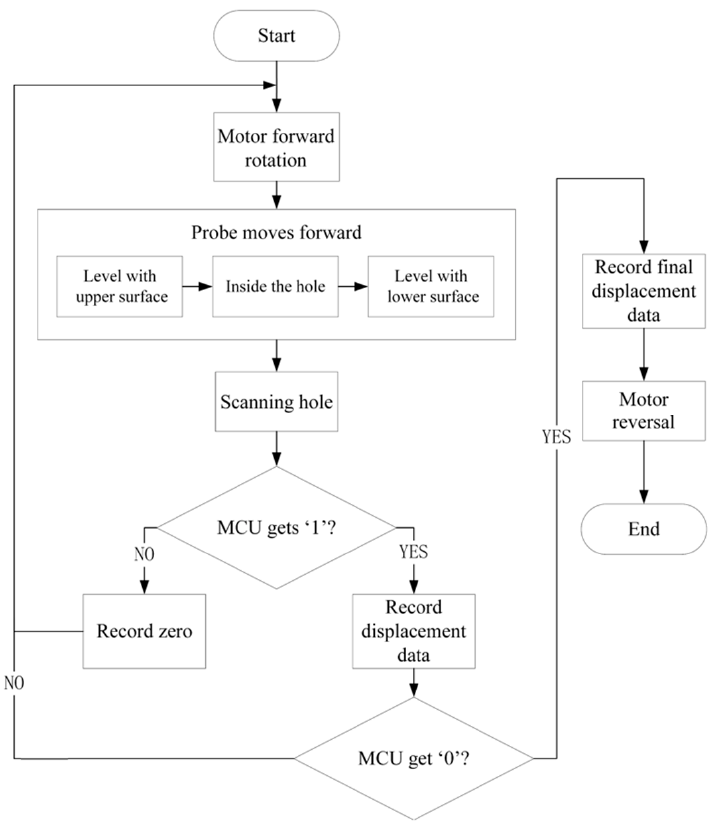
Figure 7. Control flow chart of the measurement process.